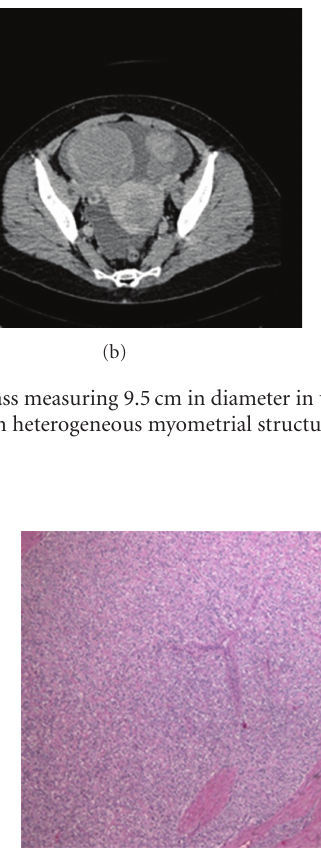
Figure 4: Endometrial stromal sarcoma, detail of stromal cells